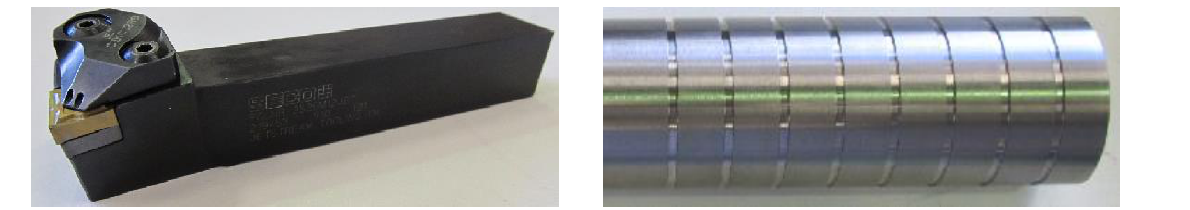
Figure 1: Machining experiment on Harrison M400